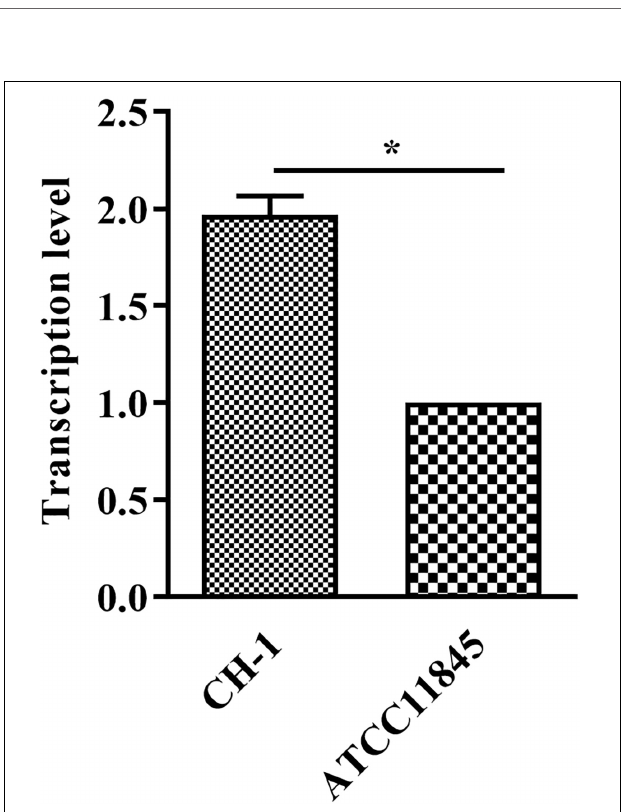
FIGURE 1 | Transcription of lptD in R. anatipestifer CH-1 and ATCC11845. RNA was extracted and performed qRT-PCR. The data were analyzed using Student’s t -test. The error bars represent the standard deviations of three independent experiments, ∗ , p <